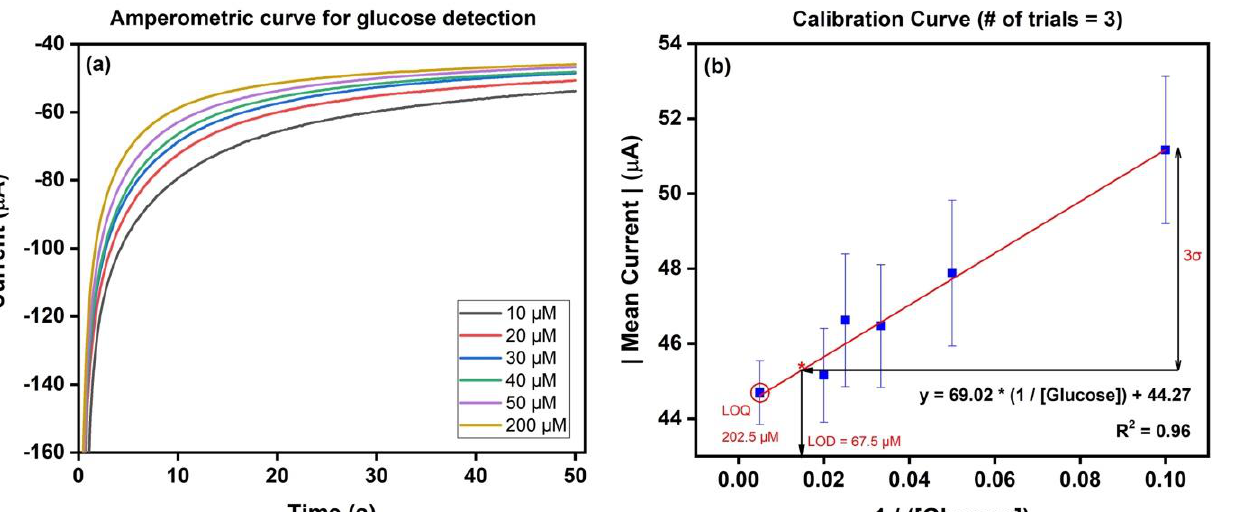
Table 2. Comparison of the present work with the available literature.